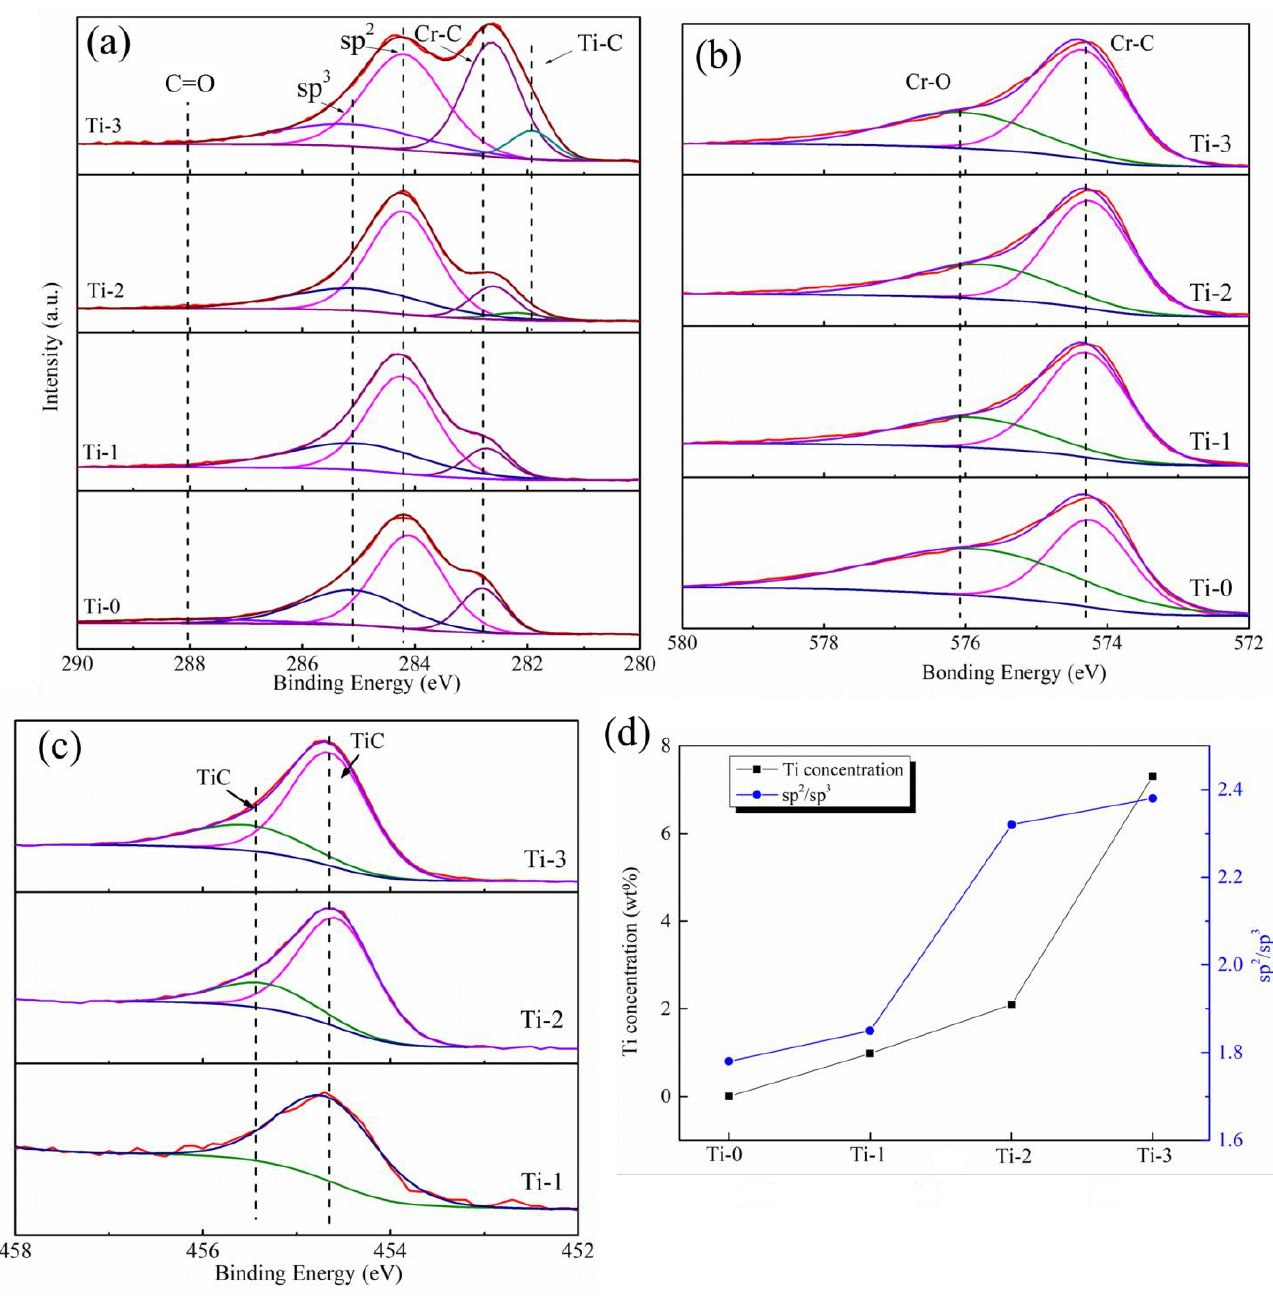
Figure 2. XPS patterns of the as-deposited composite amorphous carbon films; ( a ) C1s, ( b ) Cr 2p, ( c ) Ti 2p, ( d ) Ti content of different Ti target currents.